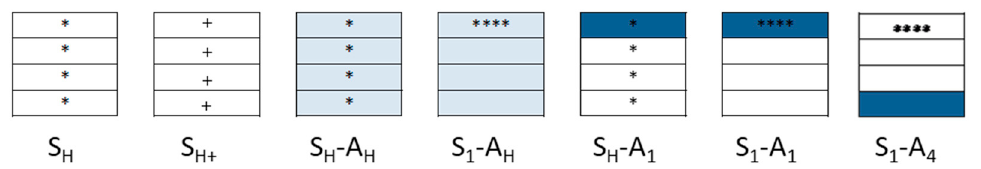
Figure 1. Overview of salt and added aroma distribution within the four layers in the four-layer cream-based snacks (FLPs). The symbol “*” represents the schematic initial salt distribution: “*” = homogeneous salt distribution (25% of overall added salt in each layer), “****” = heterogeneous salt distribution (100% of overall added salt located in one layer). S H +: unflavoured FLP containing 35% more salt than S H . Blue colours represent schematic initial added aroma distribution: “ ” = ho- mogeneous added aroma distribution (25% of the overall added aroma mix in each layer), “ ” = heterogeneous added aroma distribution (100% of the overall added aroma located in one layer).